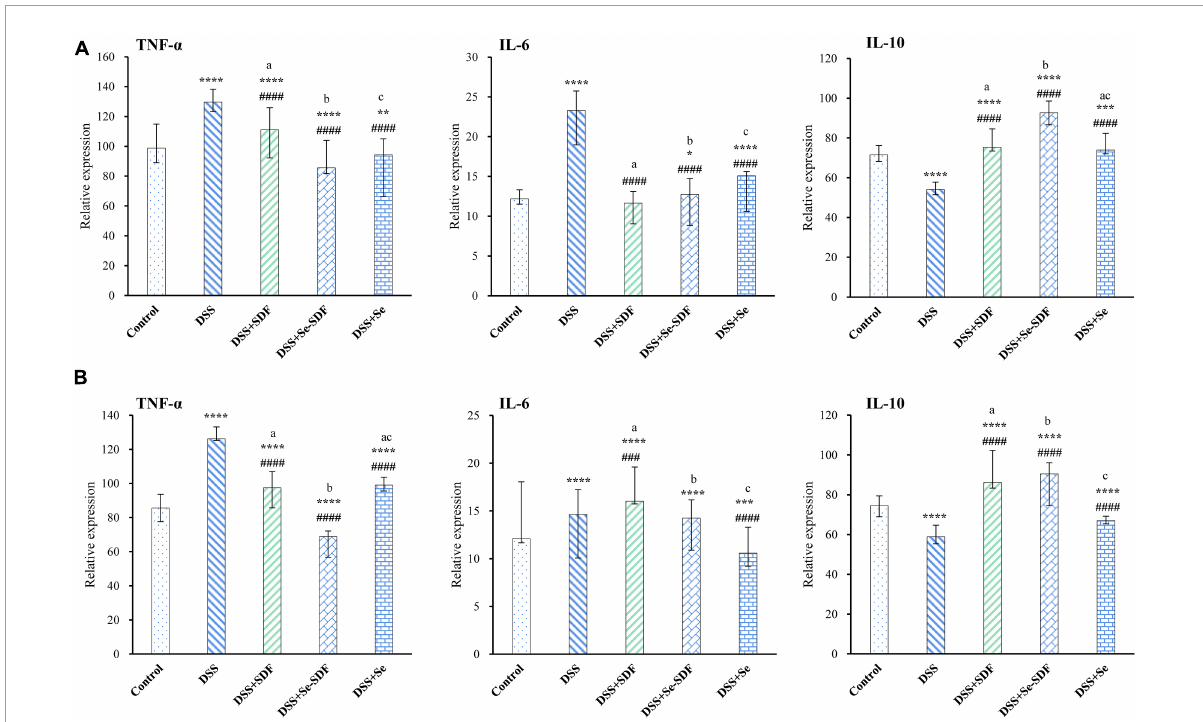
FIGURE3 Effect of Se-SDF on inflammatory factors in mice with DSS-induced colitis. (A) Inflammatory factors in female mice. (B) Inflammatory factors in male mice. Data are expressed as mean ± SD ( n = 3). * p < 0.05, ** p < 0.01, *** p < 0.001, **** p < 0.0001 vs. control group. # p < 0.05, ## p < 0.01, ### p < 0.001, #### p < 0.0001 vs. DSS group. Different letters indicate significant differences between groups ( p <